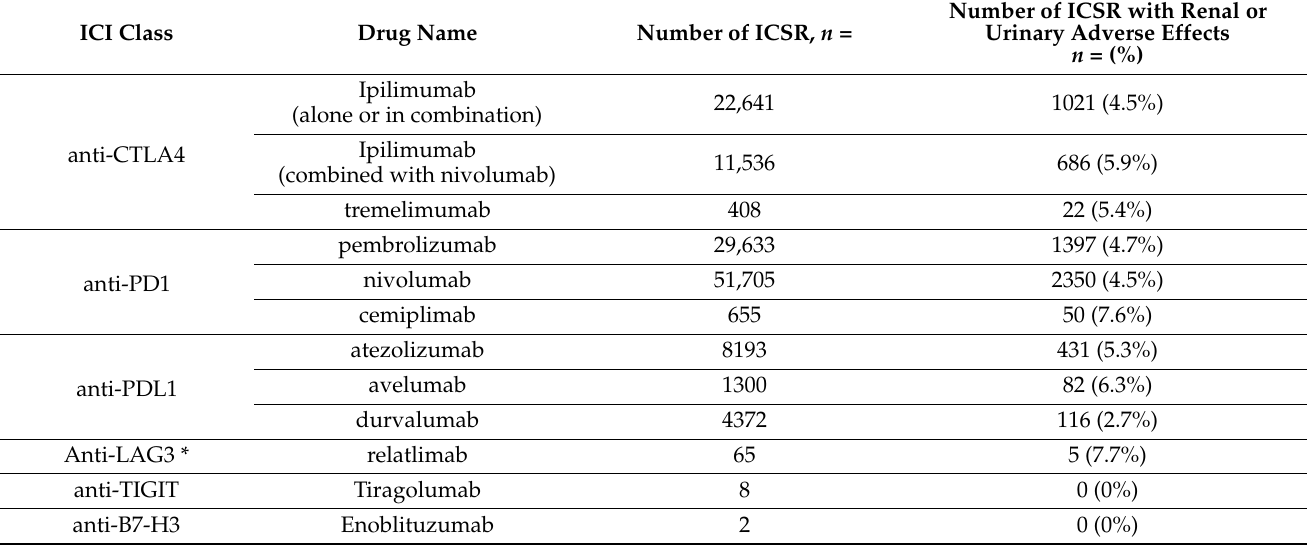
Table 2. Incidence of renal disorders in individual case safety reports (ICSRs) of suspected adverse drug reactions, according to a recent search in the VigiBase Pharmacovigilance